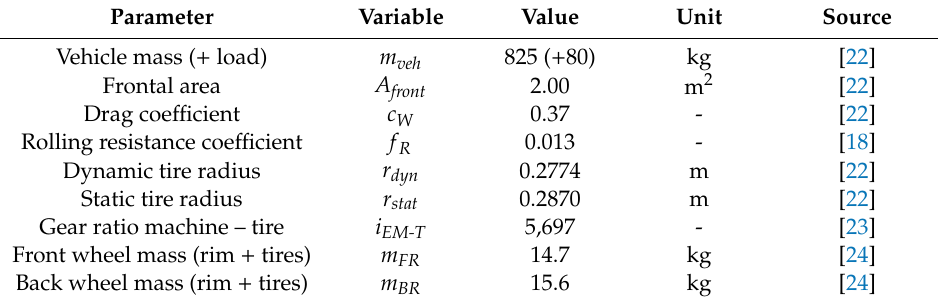
Table 1. General vehicle parameters NEmo (Smart 451 fortwo